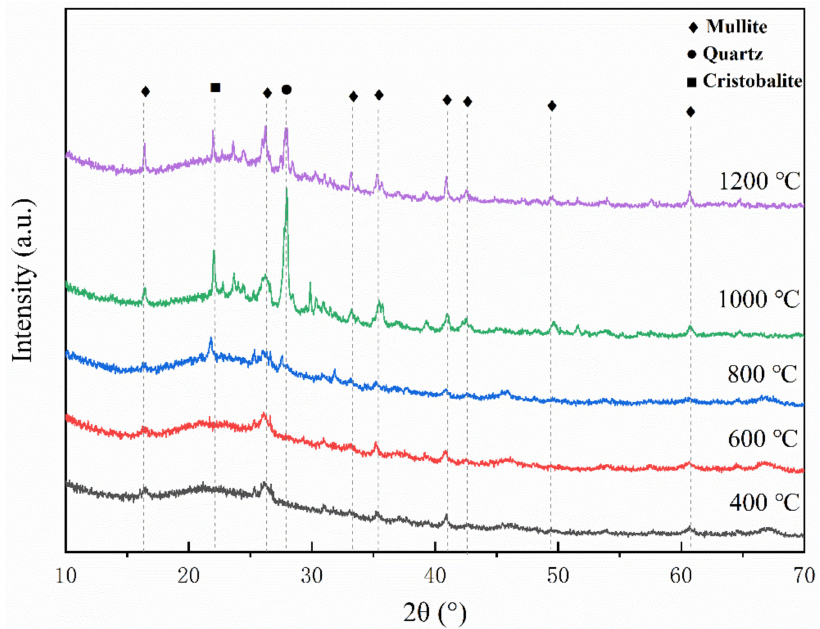
Figure 2. XRD spectrum of sample C1 after static ablation at 400 ◦ C, 600 ◦ C, 800 ◦ C, 1000 ◦ C and 1200 ◦ C.